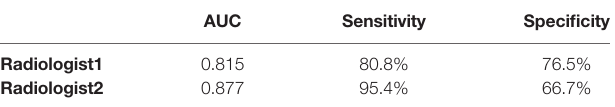
TABLE 3 | Performance of the observer reader